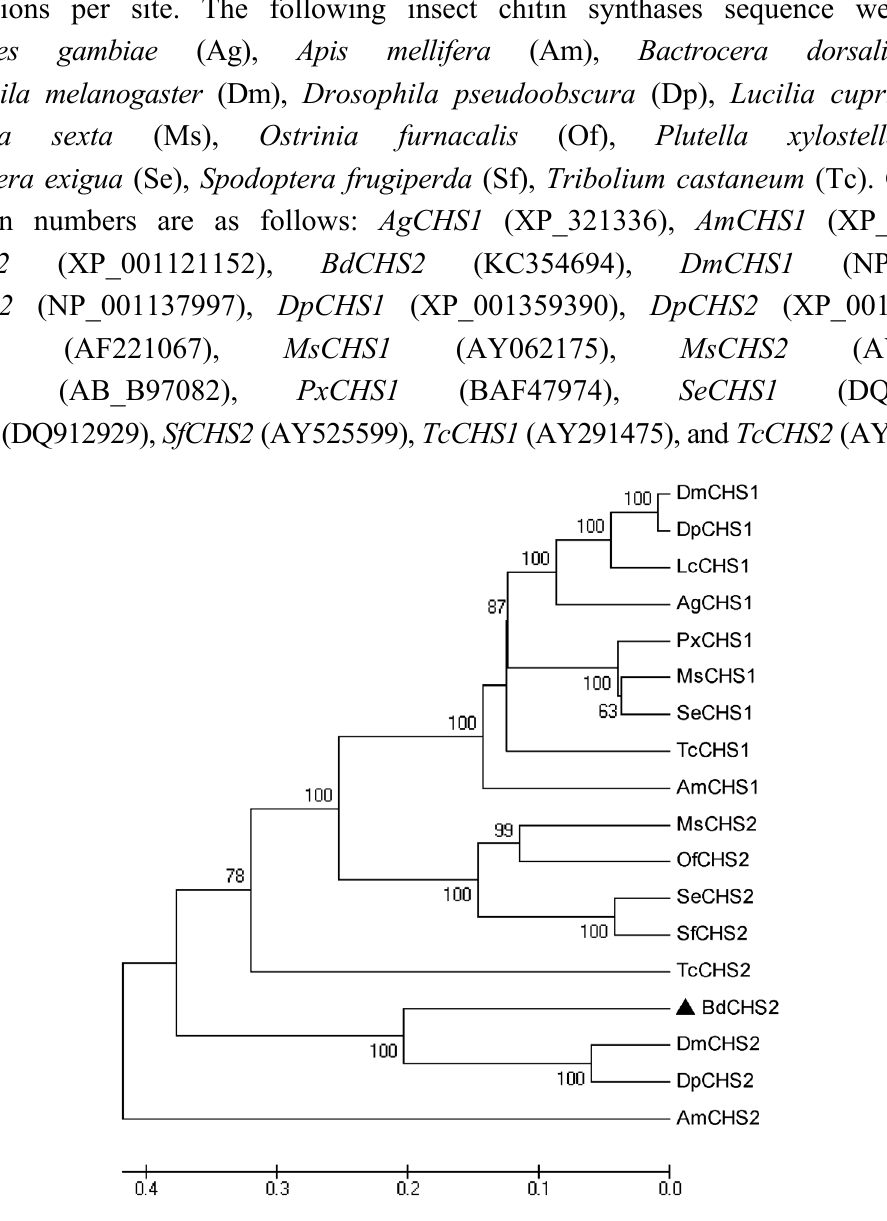
Figure 2. Evolutionary relationships of deduced amino acid sequence of BdCHS2 with other insect chitin synthases constructed using the neighbor-joining method. Bootstrap values with 1000 trials are indicated on branches. The scale bar represents the number of substitutions per site. The following insect chitin synthases sequence were